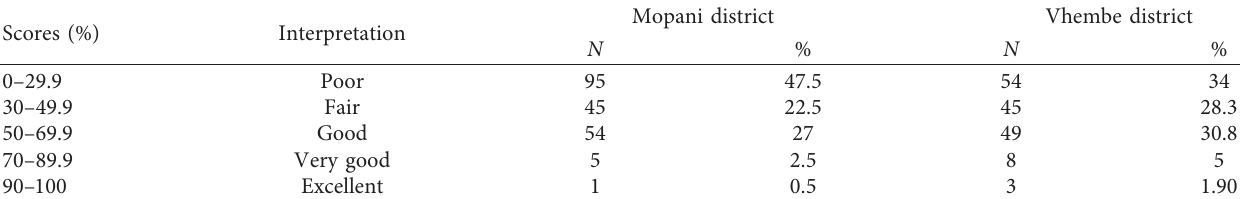
Table 6: Iodine nutrition knowledge